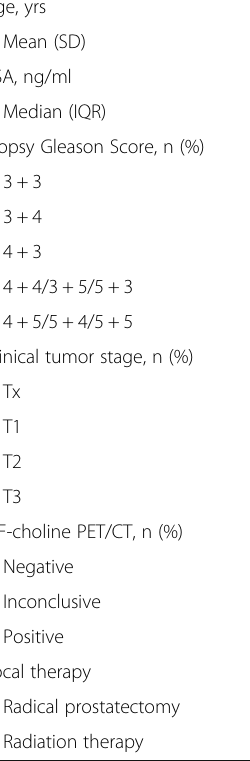
Table 1 The clinical characteristics of the 124 men who received radical local therapy Age,